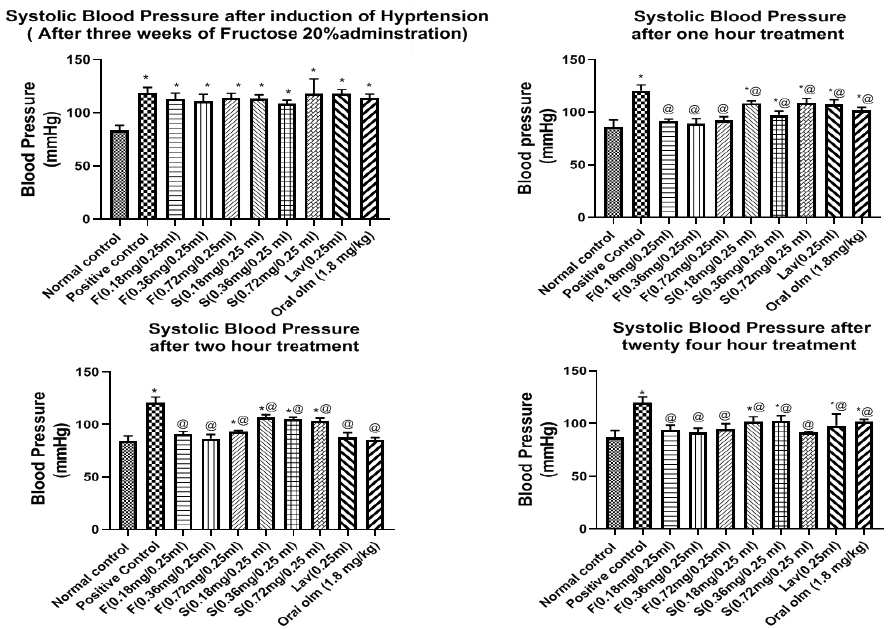
Figure 8. Systolic blood pressure of the ten examined rats’ groups after three weeks of hypertension induction, and after 1, 2, and 24 h of treatment. Presented data are the mean ± SD (n = 3). Abbrevia- tions: F = Transdermal oleogel formulation, S = Transdermal standard gel, Lav= Transdermal Lavender oil (0.25 mL), Oral Olm = Oral Olmesartan Medoxomil market tablet (Angiosartan ® Tablets). * Signi fi cantly di ff erent from the normal control group at respective time interval ( p < 0.05). @ Significantly di ff erent from positive group at respective time interval ( p < 0.05).